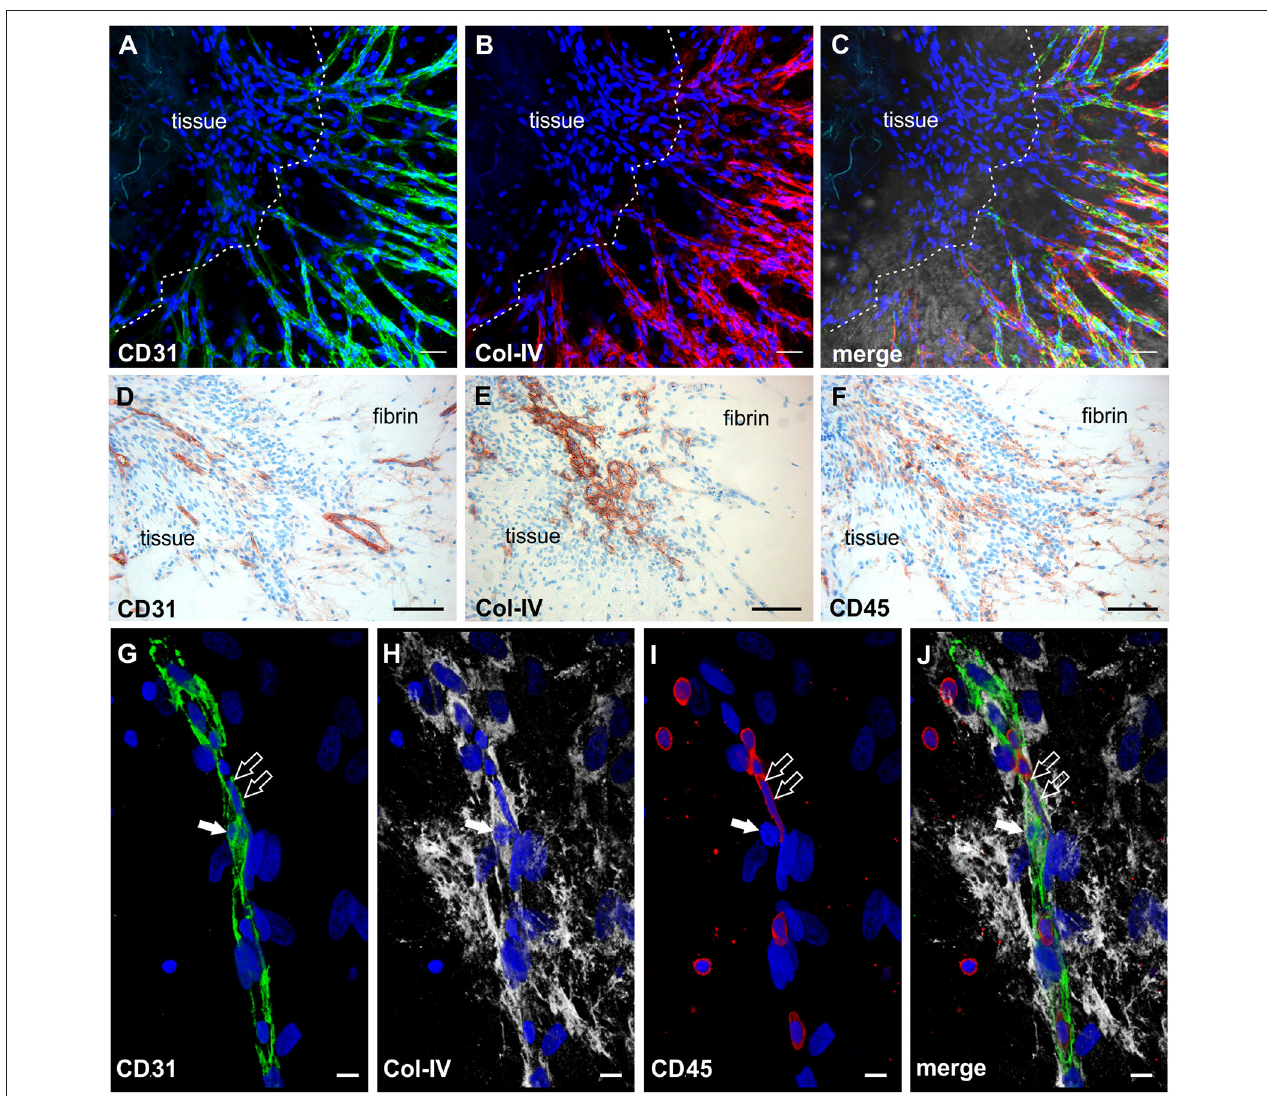
FIGURE 2 | Neo-vessel growth from synovial explants occurs in association with inflammatory cells. Complex vascular network within the fibrin matrix originating from the embedded tissue fragment expressing (A) CD31 (green) and showing (B) Col-IV positive basement membrane and mural cells (red). (C) Merged image of (A,B) demonstrating partial co-expression of CD31 and Col-IV. The tissue itself is unstained due to poor penetration of antibodies. (A–C) CLSM images of an intact fibrin gel on day 19, collapsed 13 µ m-z-stack consisting of 9 consecutive images. Scale bars, 50 µ m. (D) Cultured tissue fragment showing CD31 + vessels that grow in direction of the surrounding fibrin matrix and CD31 + vascular structures within the fibrin gel. (E) Cultured synovial tissue containing numerous round Col-IV positive clusters. (F) Intra-synovial neo-vessels aligned and closely associated with CD45 + inflammatory cells. (D–F) Immunohistochemistry on consecutive paraffin sections of a day 28 explant culture sample. Scale bars 100 µ m. (G–J) Immature vascular sprout developing within the fibrin matrix consisting of (G) CD31 + endothelial cells that are surrounded by (H) Col-IV + stromal cells. (I) Numerous CD45 + leukocytes are integrated in the growing cell cord and surround the vascular sprout. Note the CD45 − dividing cell that co-expresses CD31 and Col-IV (arrow) and the elongated nucleus of the CD45 + cell (open arrows) with (J) partial co-expression of CD31. CLSM images of an intact fibrin gel on day 20, collapsed 15 µ m-z-stack consisting of 16 consecutive images. All images are shown with DAPI counterstain in blue. Scale bars, 10 µ